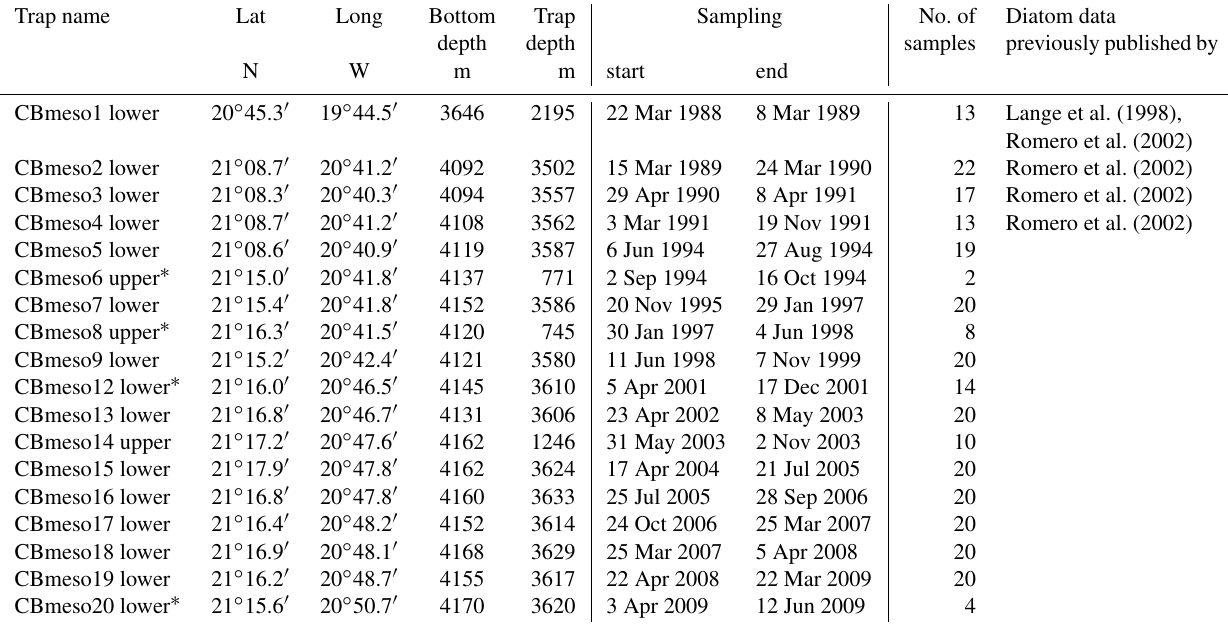
Table 1. Data deployment at the site CBmeso (Cape Blanc mesotrophic): trap name, coordinates (latitude and longitude), ocean bottom depth, trap depth, sampling interval, and sample